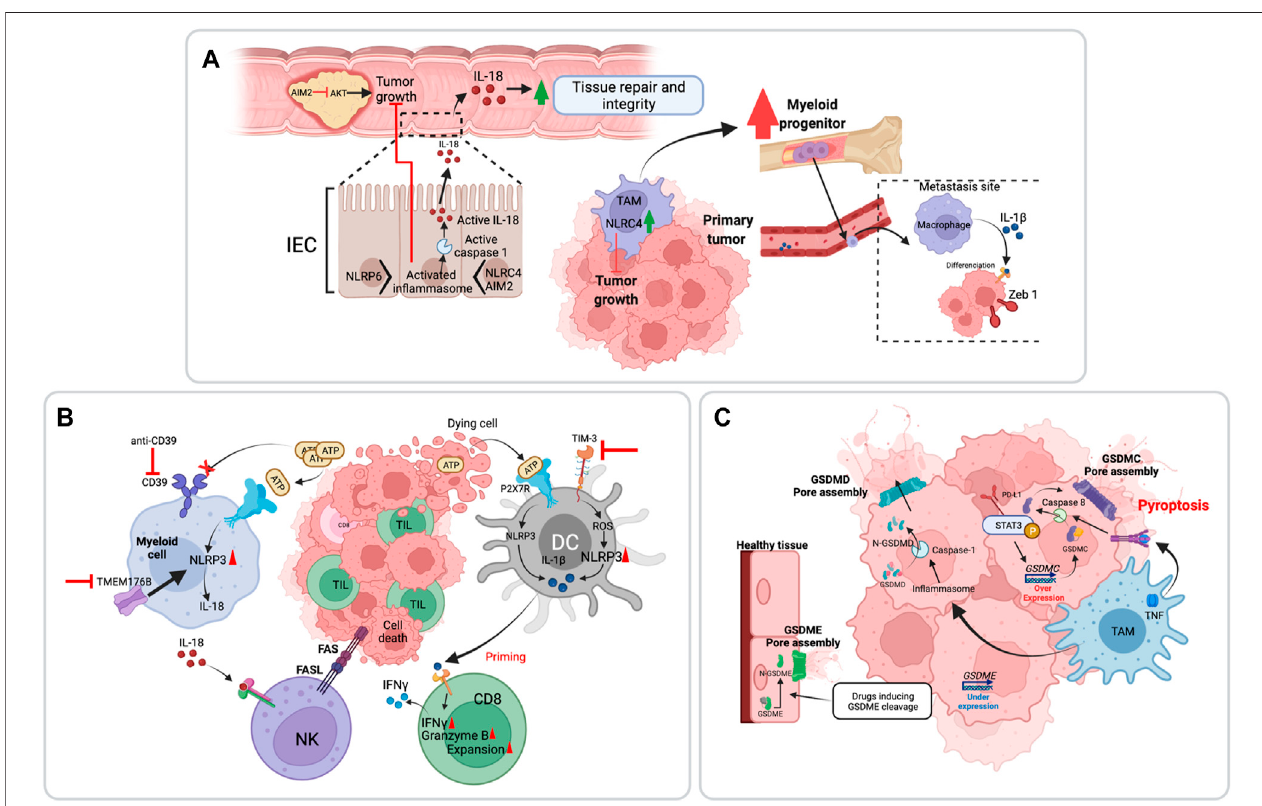
FIGURE 3 | Anti-tumoral functions of the in fl ammasome pathway. (A) The in fl ammasome can suppress tumor cell proliferation and promotes tissue homeostasis and celldifferentiation. (B) In fl ammasome activationfavorsanti-tumorimmunitybyenhancingNKandCD8Tcelltumorilyticactivities.ThisisprimarilymediatedbyIL-18. In fl ammasome triggers enhance the ef fi cacy of immune checkpoint inhibitors. (C) Pyroptotic cell death downstream of in fl ammasome activation establishes an immunogenic environment through the release of several DAMPs and immunostimulatory molecules. Pyroptosis is initiated by caspase-dependent processing of gasderminsthatformporesleadingtoosmoticlysisofthecell.Certainchemotherapiesinducetoxicitiesbecauseofpyroptoticdeathofhealthycellsthroughgasdermins E cleavage by caspase-3.